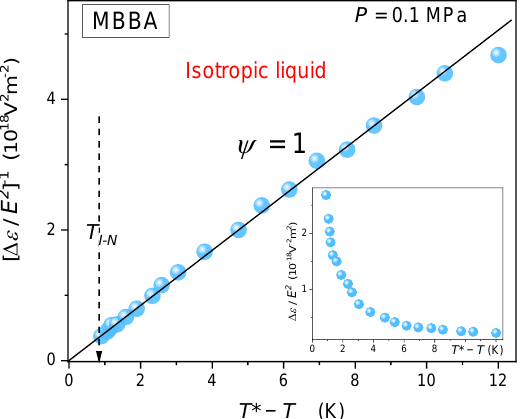
and the 𝐼−𝑁 − 𝑇 ∗ = 0.8 𝐾 . 𝐼−𝑁